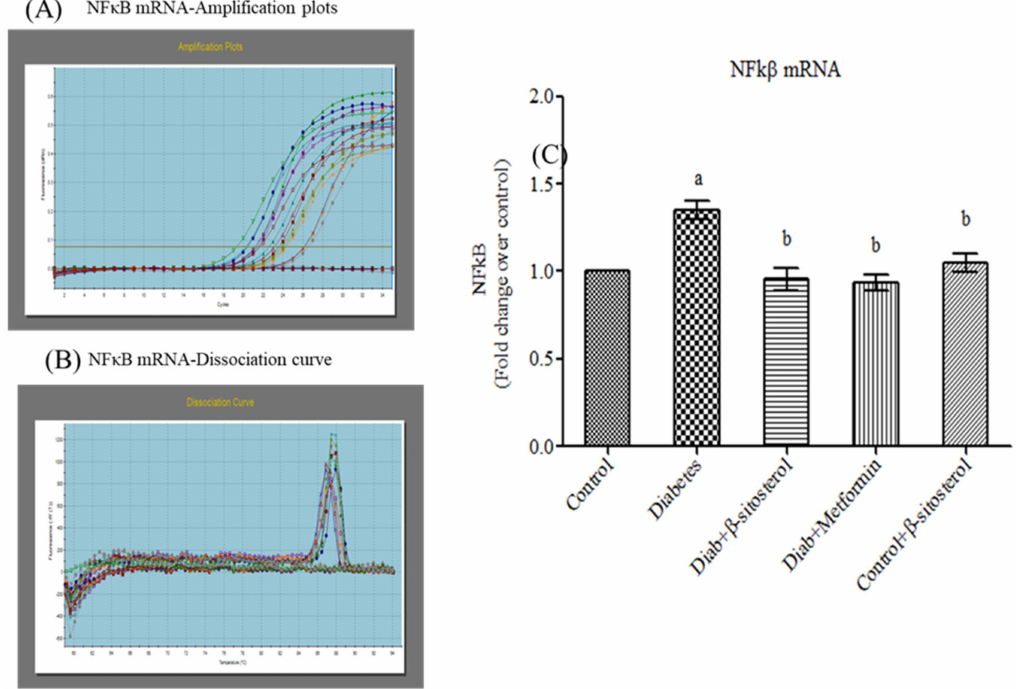
Figure 11. Effect of SIT on mRNA expression of NF- κ B in adipose tissue of type-2 diabetic rats. The mRNA expression of NF- κ B was assessed by real time-PCR. ( A ): Amplification plots; ( B ): dissociation curve analysis confirms the single product of NF- κ B mRNA and ( C ): mRNA expression is given in fold change. Each bar represents mean ± SEM ( n = 6). Significance at p < 0.05. a Significantly different from the control group; b significantly different from the diabetic